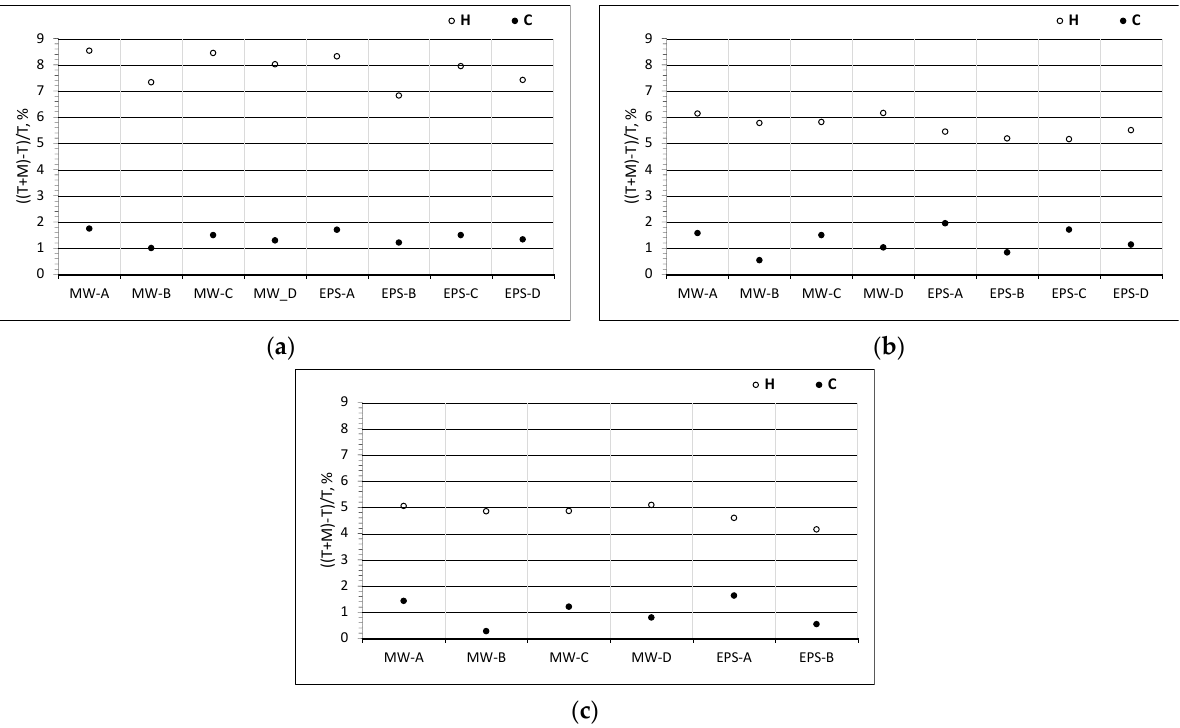
Figure 2. Percentage change of energy consumption for heating, ventilation and cooling with or without moisture for climate data from Warsaw and an 8 cm thick thermo-insulation layer, ( a ) one external wall, ( b ) two external walls, ( c ) three external walls.